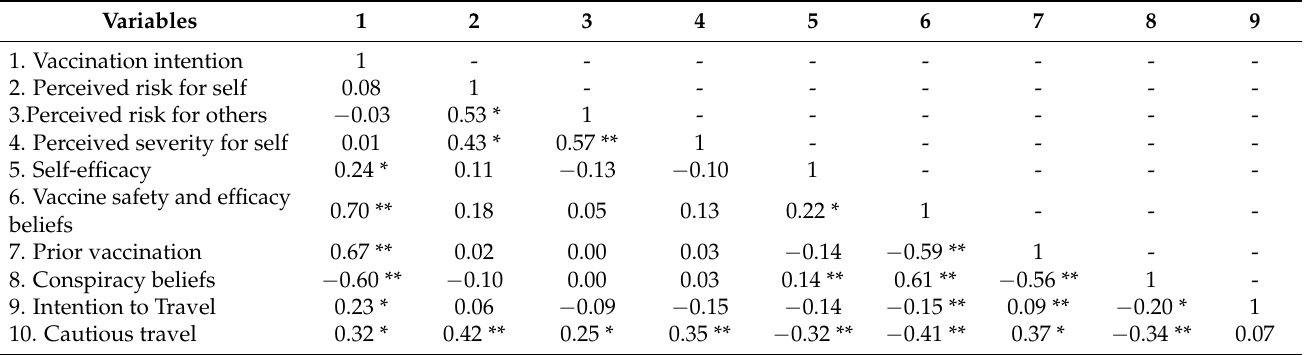
Table 3. Correlation Coefficients between Vaccination Intention and Perceived Exposure, Risk, Self-Efficacy, Vaccine Safety, Vaccination Status, Conspiracy Beliefs and Intention to